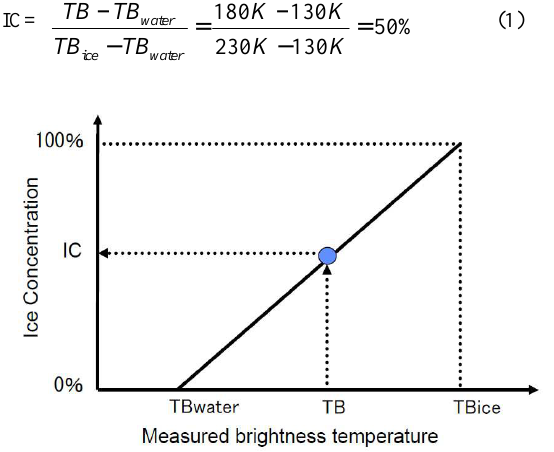
Specifications of AMSR2 Figure 2(a) and (b) show the sea ice concentration(IC) image derived from AMSR2 using Bootstrap Algoritm (Comiso, 1995) and MODIS image taken on February 27, 2013 respectively. In Figure 2(a), black corresponds to IC=0% and white corresponds to IC=100%. Figure 3 shows the schematic diagram of calculating ice concentration (IC) from brightness temperatures derived from passive microwave radiometers. In passive microwave region, due to the emissivity differences, the brightness temperature of big ice floe (TBice: for an example 230K) is much higher than that of open water (TBwater: for an example 130K). Thus, if the brightness temperature TB of Specifications of MODIS